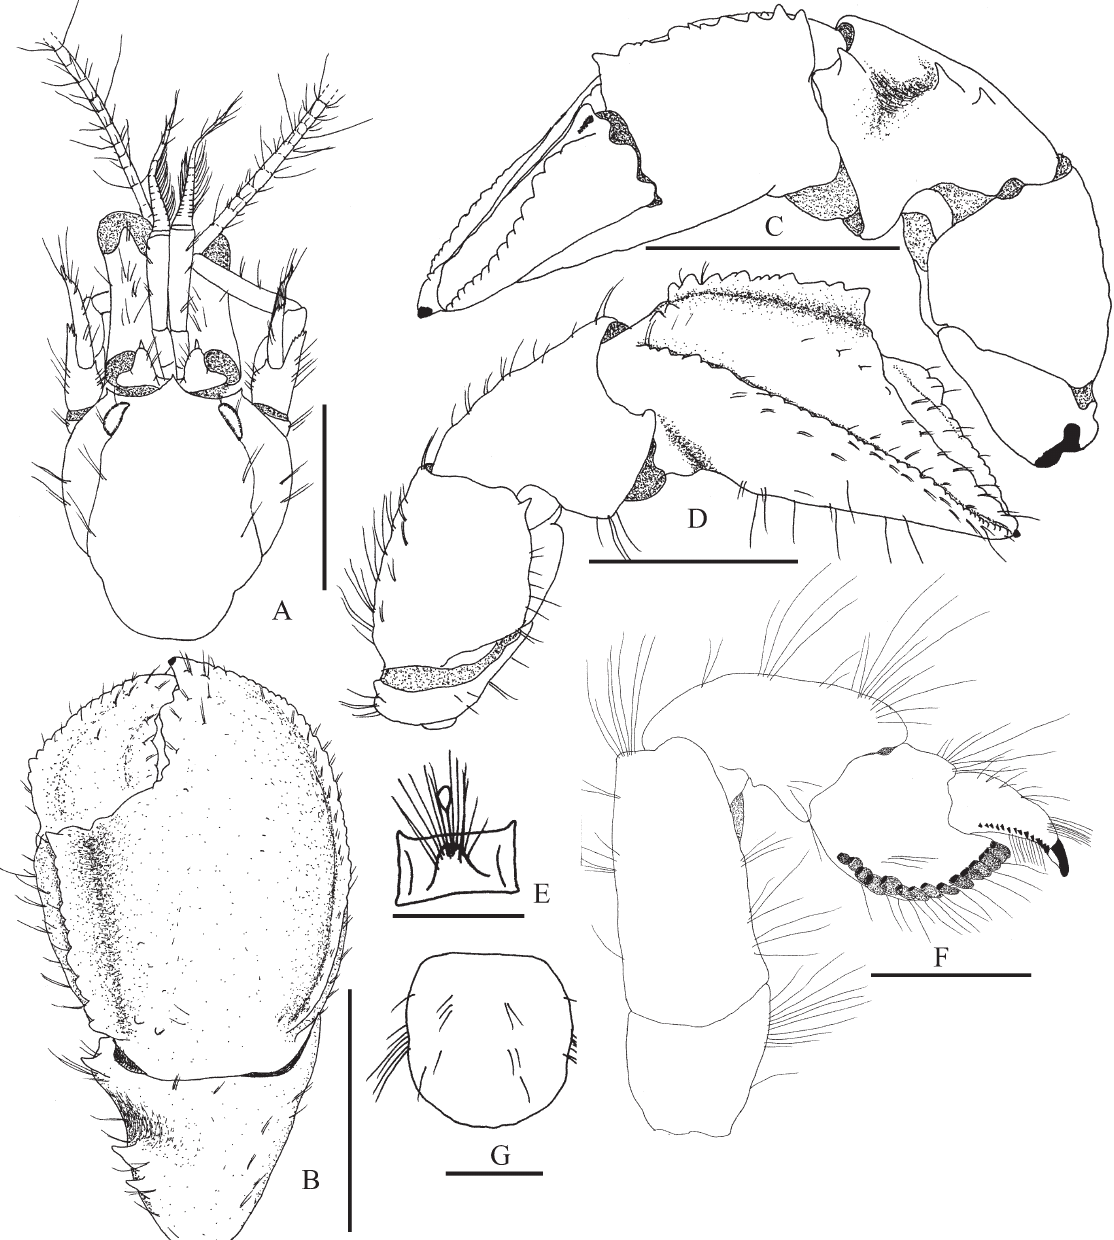
line, with row of small spines or spinules;